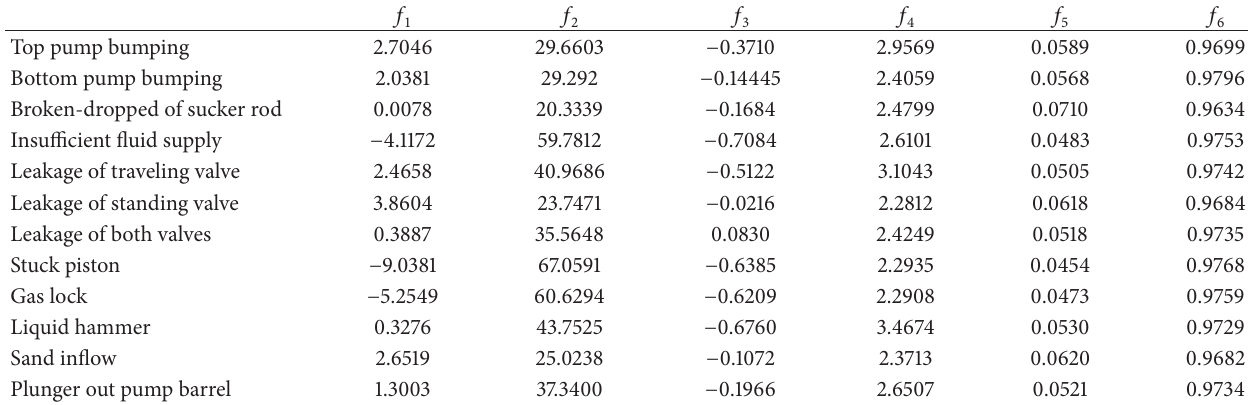
Table 3: Gray Level Matrix Statistics of typical faults indicator card.